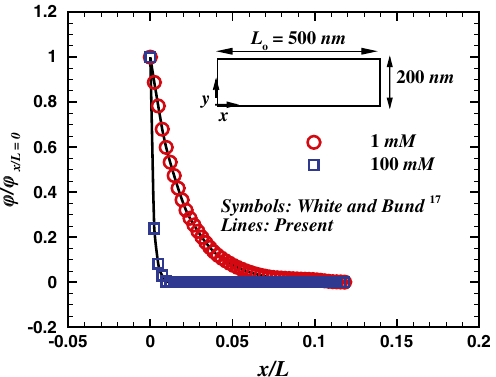
Figure 2. Comparison of the variation of cross-sectional potential profile with White and Bund 17 at ρ